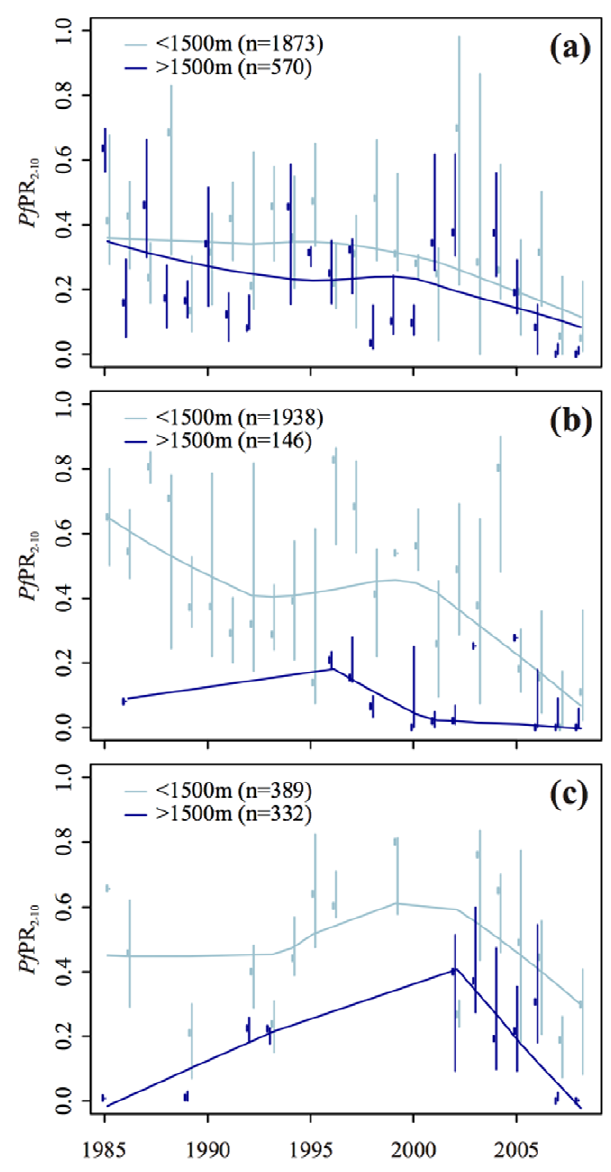
Figure 5. Plasmodiumfalciparum parasite rate survey data by year for five East African countries. Time series plots summarizing available community P. falciparum parasite rate survey data for (top) Kenya, (middle) Tanzania and (bottom) the combined region of Burundi, Rwanda, and Uganda. Data are stratified into low and high altitude regions and summarized by the median (dots) and interquartile range (bars) of surveys available in each year. Smoothed lines show the LOWESS-smoothed moving average. Pf PR 2-10 : Plasmodium falciparum parasite rate in the age-standardized two-up-to-ten year old age range (Smith et al .